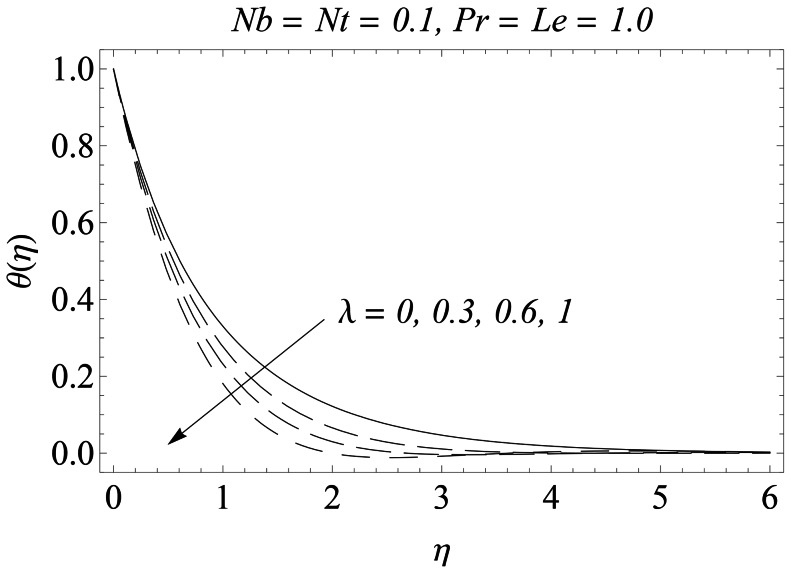
Influence of λ on .